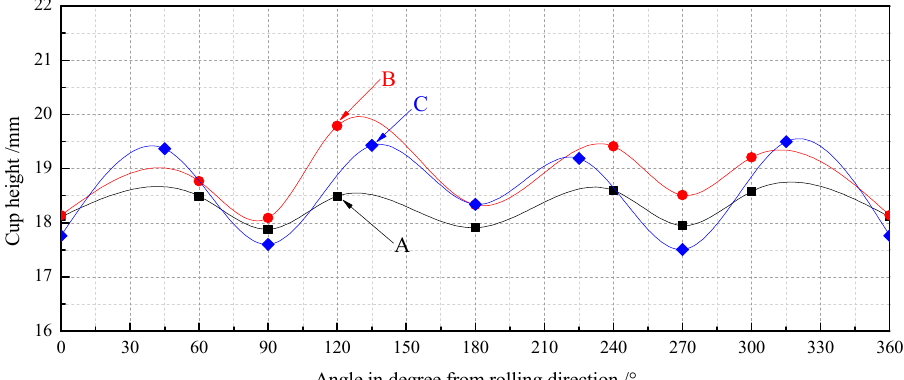
Figure 9. Earing heights at varied angels from rolling direction.